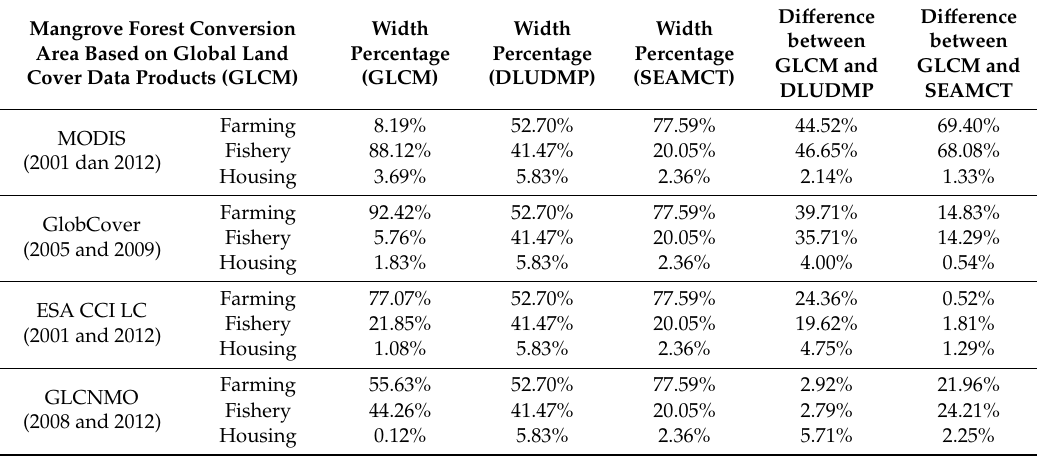
Table 7. Conformity percentage between each data product with DLUDMP land use classes and SEAMCT based on the area of deforested